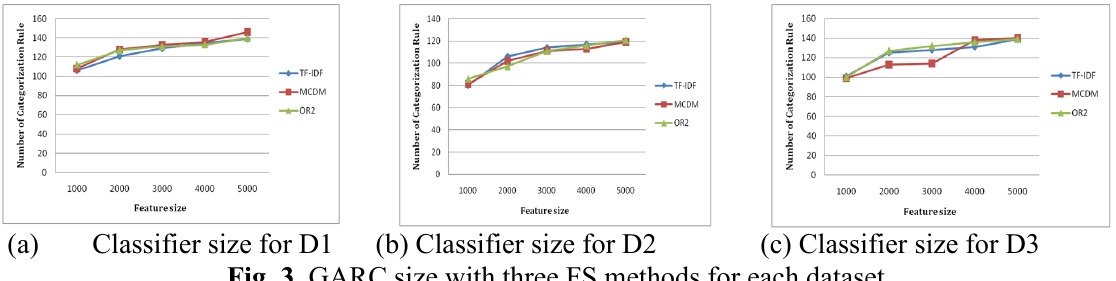
Fig. 3. GARC size with three FS methods for each dataset